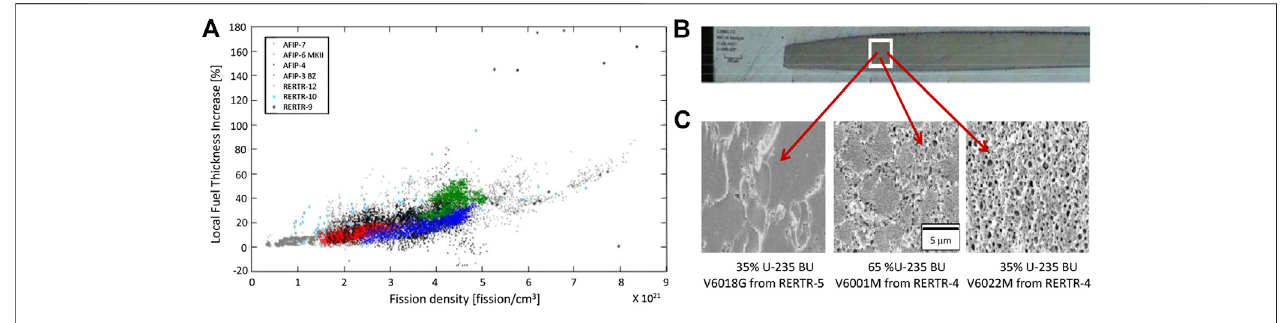
FIGURE 1 | Experimental results reproduced from references (Kim et al., 2013; Meyer et al., 2017). (A) UMo fuel meat thickness change vs. fi ssion density (Meyer et al., 2017), (B) pro fi le of radiated UMo fuel meat, and (C) evolution of recrystallized grains and gas bubbles in UMo fuel meat (Kim et al., 2013).